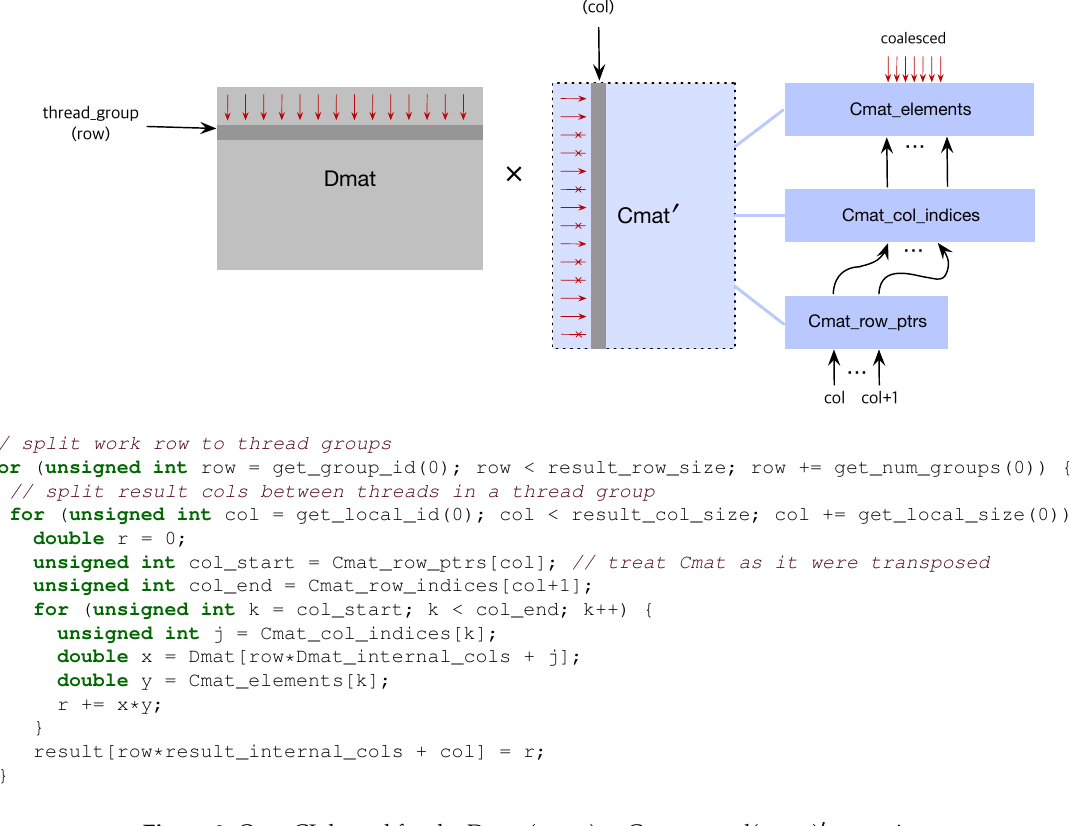
Figure 2. OpenCL kernel for the Dense( Dmat ) × Compressed( Cmat ) (cid:48)